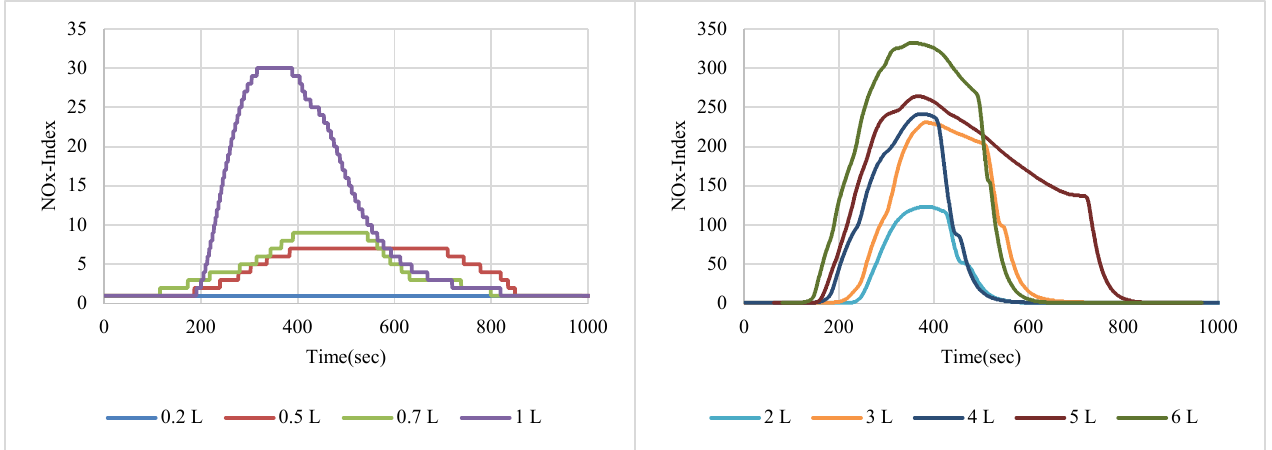
Figure 9. NOx-Index response for NOx car exhaust gas sample 2.